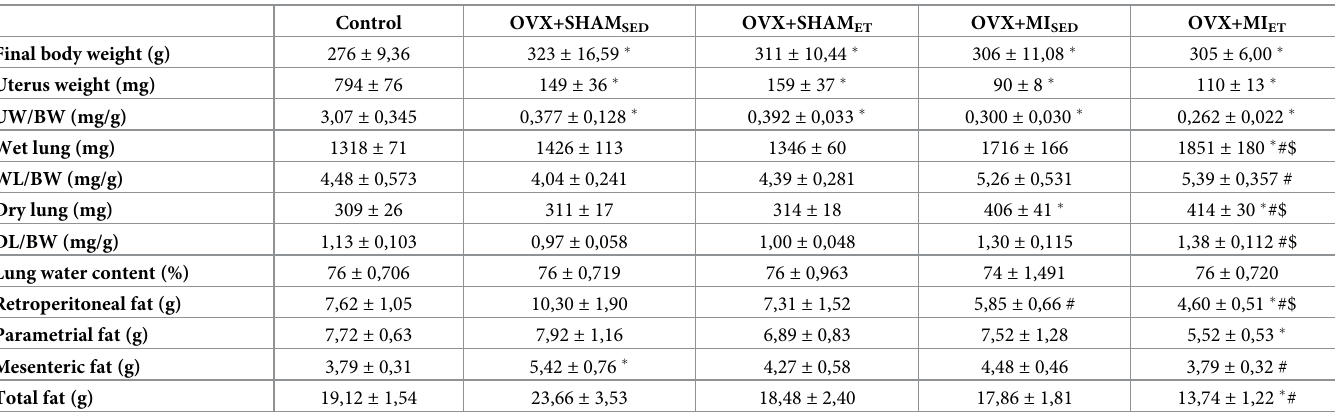
Table 1. Body and organ weights.